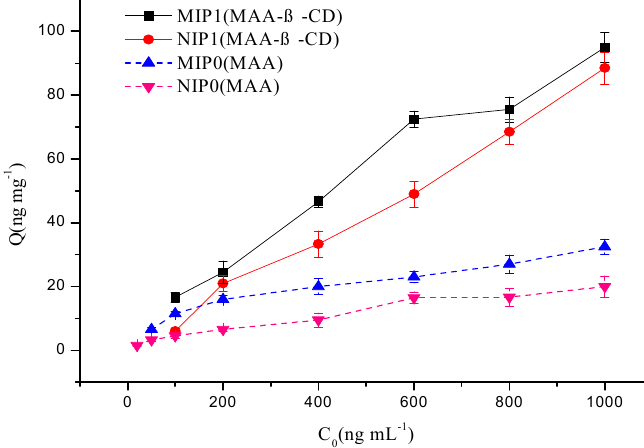
Figure 5. ATP binding to MIPs and NIPs with different monomers (MAA and MAA- β -CD) in aqueous media. Each data represents mean ± SEM ( n = 3).